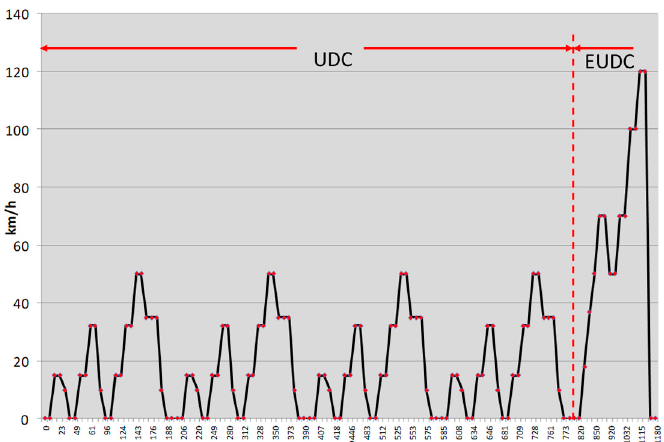
Figure 14. NEDC driving cycle.